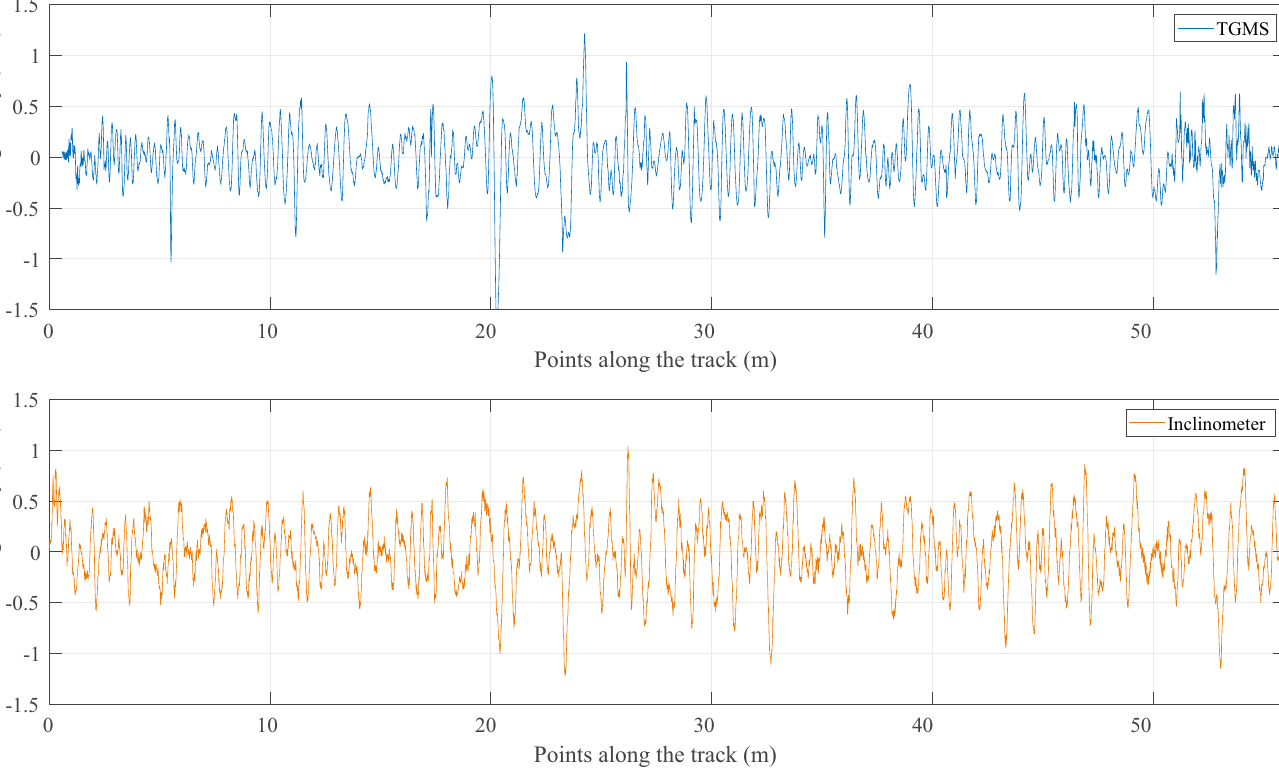
Figure 16. Measurements of cross